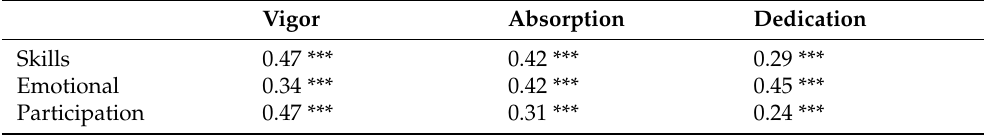
Table 5. Zero-order Correlations between the Italian OSE Scale and the Italian UWES-S-9 dimensions. Vigor Absorption Dedication Skills 0.47 *** 0.42 *** 0.29 *** Emotional 0.34 *** 0.42 *** 0.45 *** Participation 0.47 *** 0.31 *** 0.24 *** *** p <